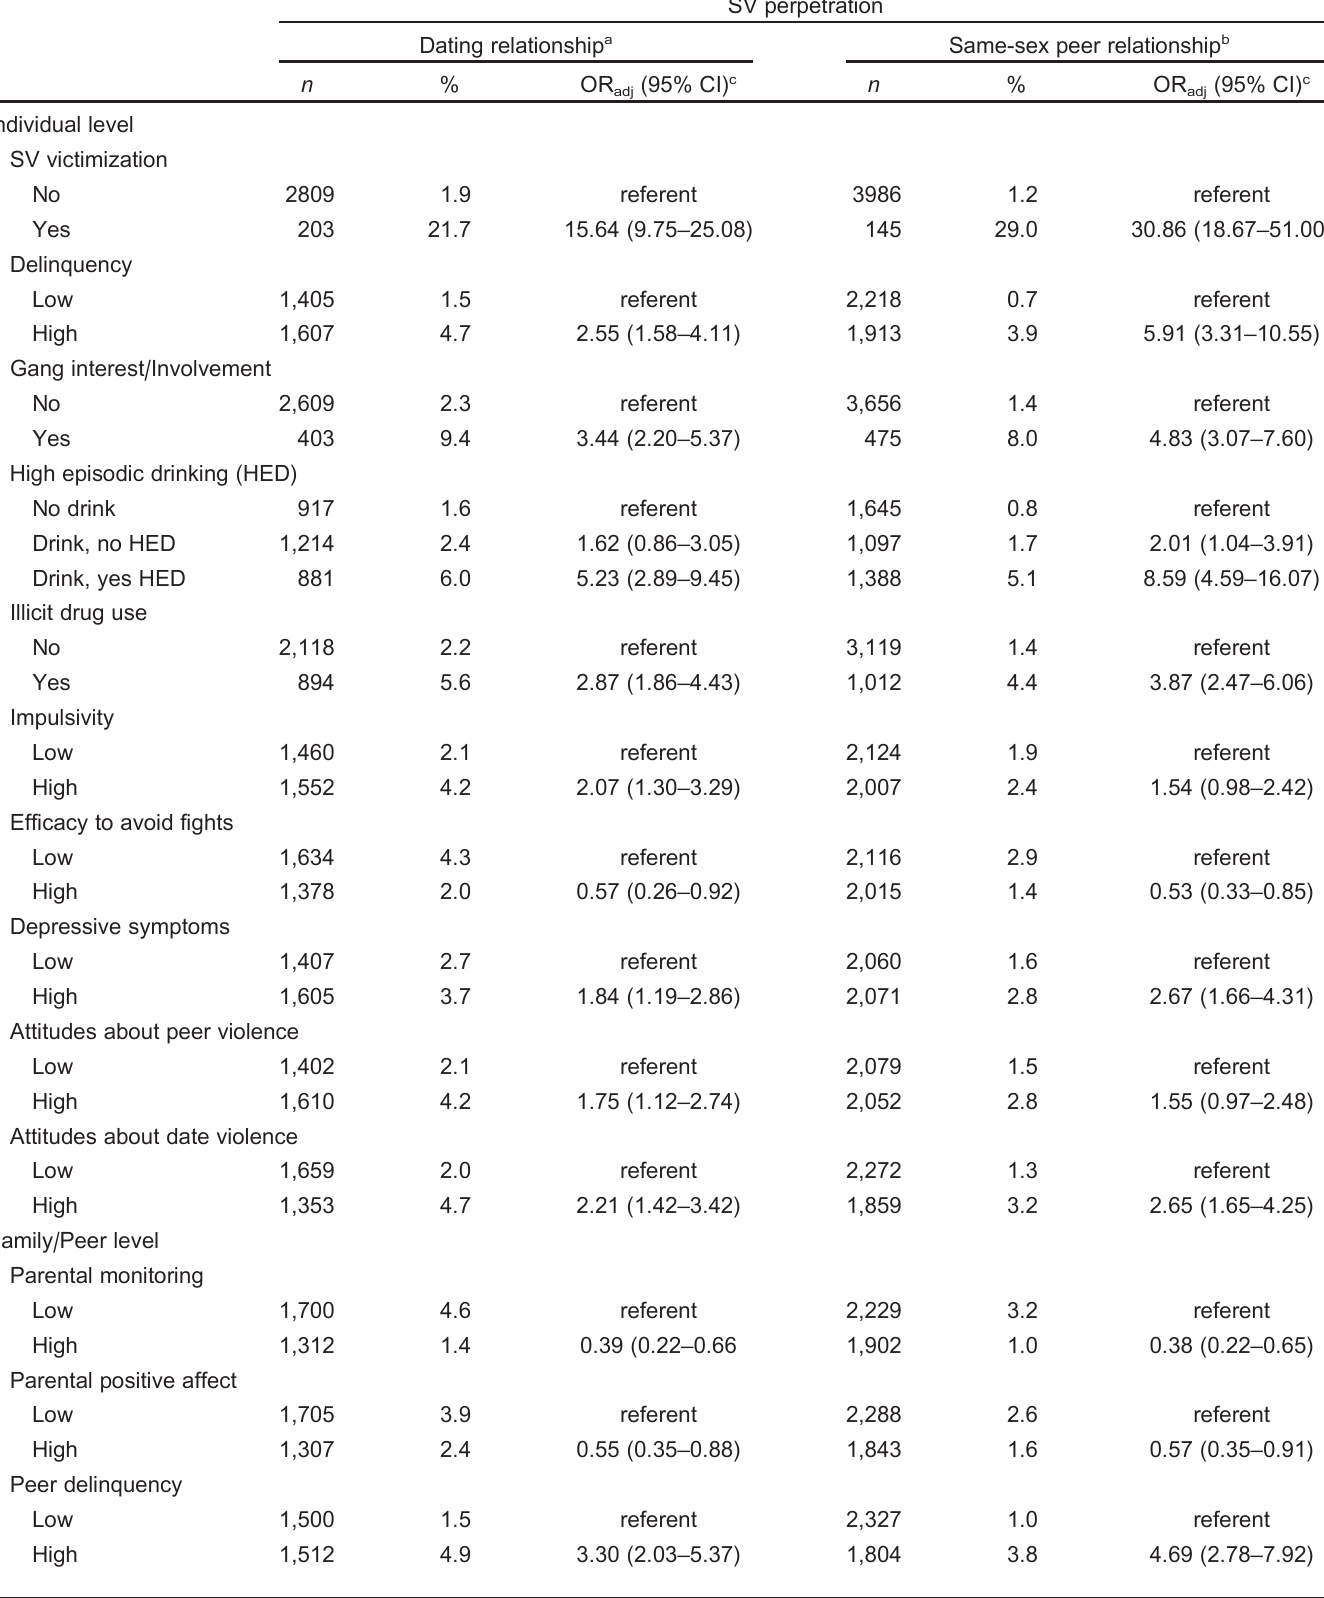
Table 1. Logistic regression analyses of the associations between risk and protective factors and perpetration of sexual violence (SV) across dating and same-sex peer relationships among high risk youth in grades, 7, 9, 11, and